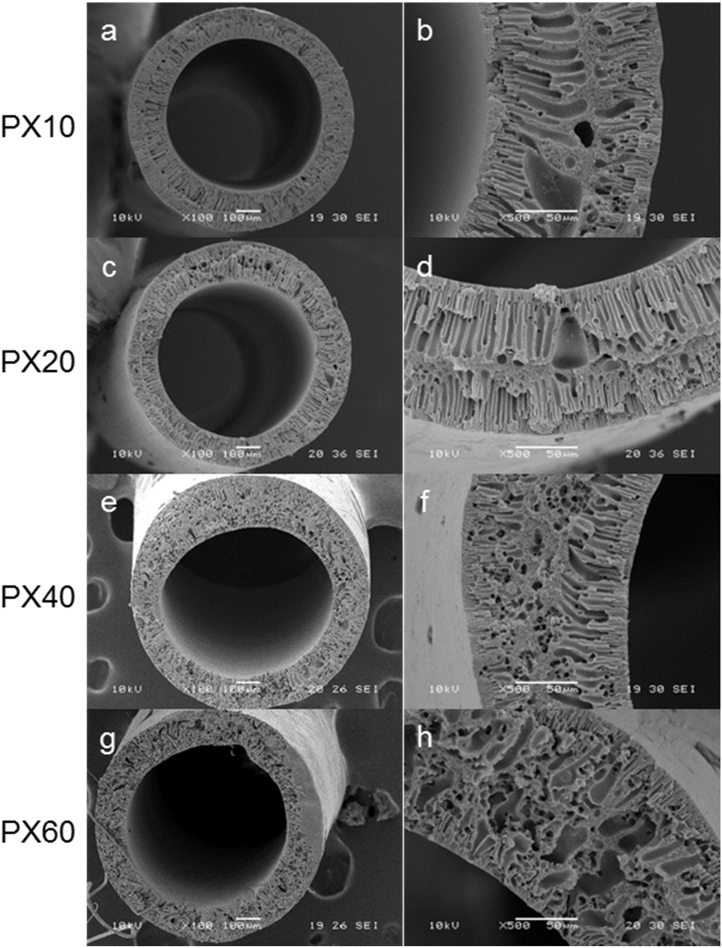
SEM micrographs of hollow fibre cross-sections. Typical structures of (a, b) PX10; (c, d) PX20; (e, f) PX40; (g, h) PX60. Left hand column scale bars represent 100 µm; right hand column scale bars represent 50 µm.